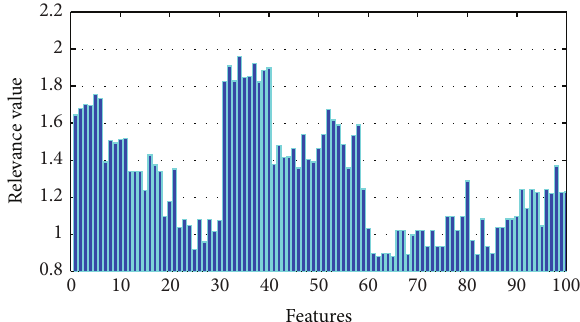
Figure 9: Relevance values of the features calculated by mutual information.